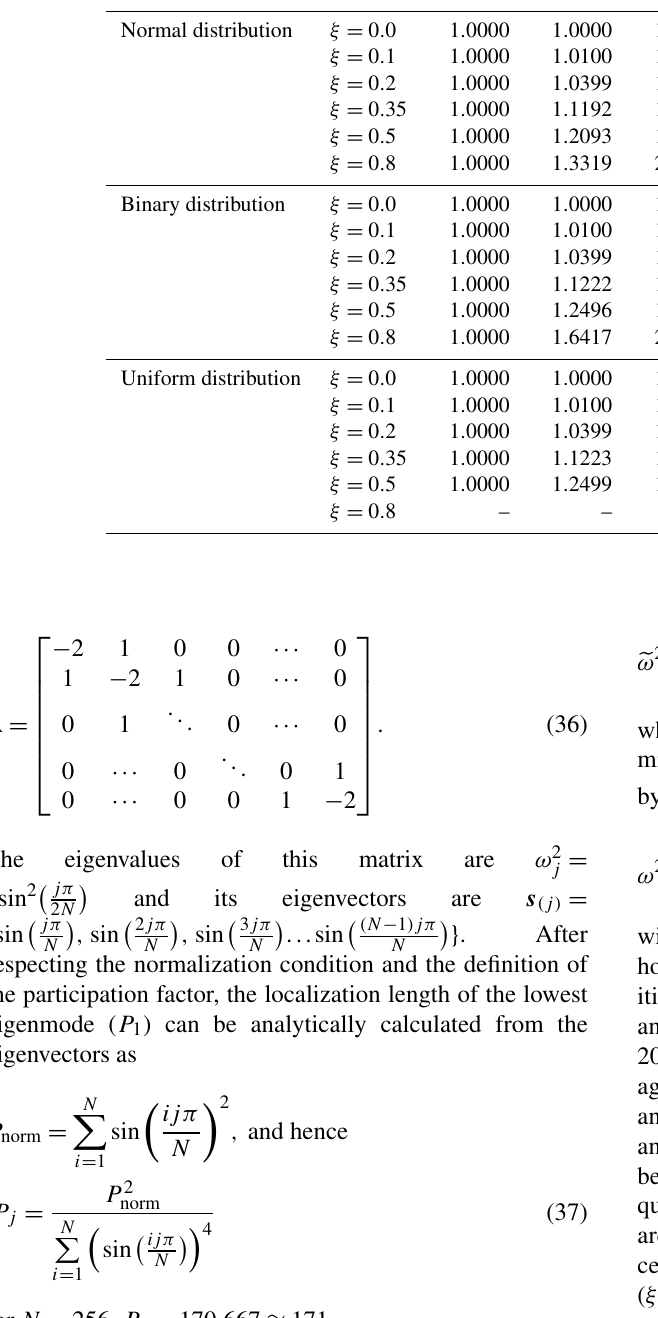
Table 3. Moments of ensemble-averaged distributions (10000 ensembles) used for the one-dimensional chain (256 elements long).